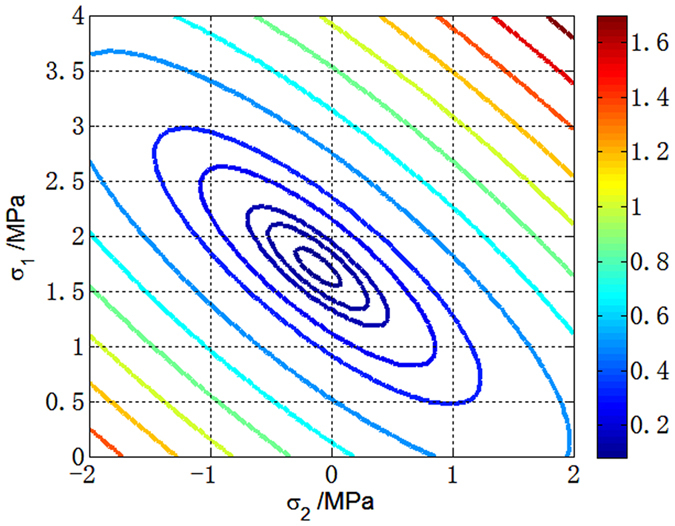
Distribution of the error function e(σ1, σ2) when θ = 13°.